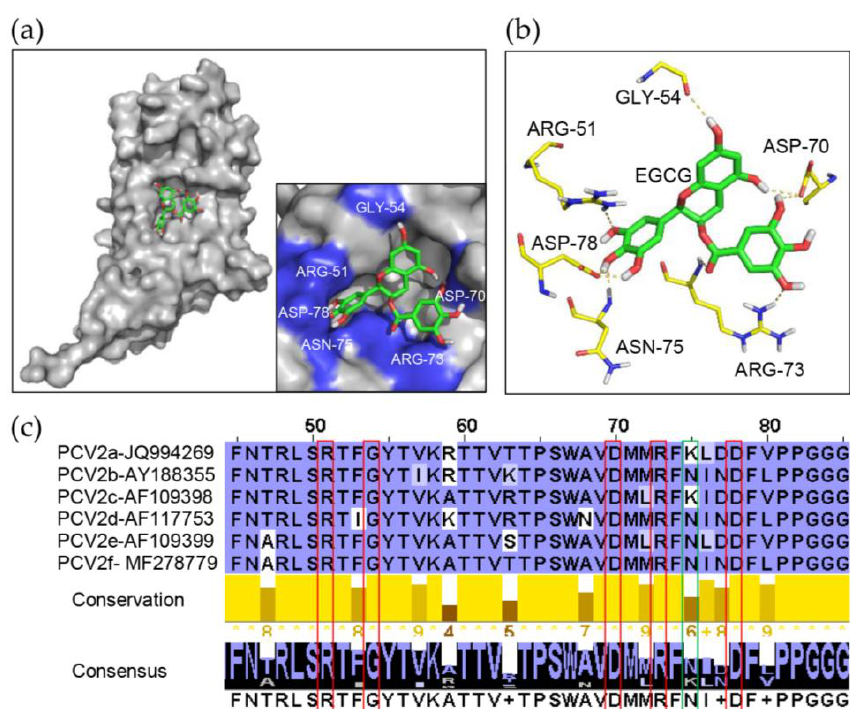
Figure 5. Molecular docking model of interaction between EGCG and PCV2 Capsid. ( a ) Structural diagram of EGCG-capsid complex based on the flexible docking model. The amino acids involved in the formation of the pocket accommodating EGCG molecule (green) were labeled blue in the dcapsid (light grey) in the zoom graph. ( b ) The putative amino acids (yellow) in dcapsid that could establish hydrogen bonds with EGCG (green) based on the docking model. The predicted hydrogen bonds are shown as a yellow dotted line. ( c ) The conservation of the key amino acids in the capsid to maintain the interaction among PCV2 subtypes. All the amino acid sequence data were obtained from GenBank. Among the predicted amino acids which might form hydrogen bonds with EGCG, the ones with high conservation (ARG-51, GLY 54, ASP-70, ARG-73 and ASP-78) are highlighted with a red frame, and the rest (ASN-75) are labeled with a green